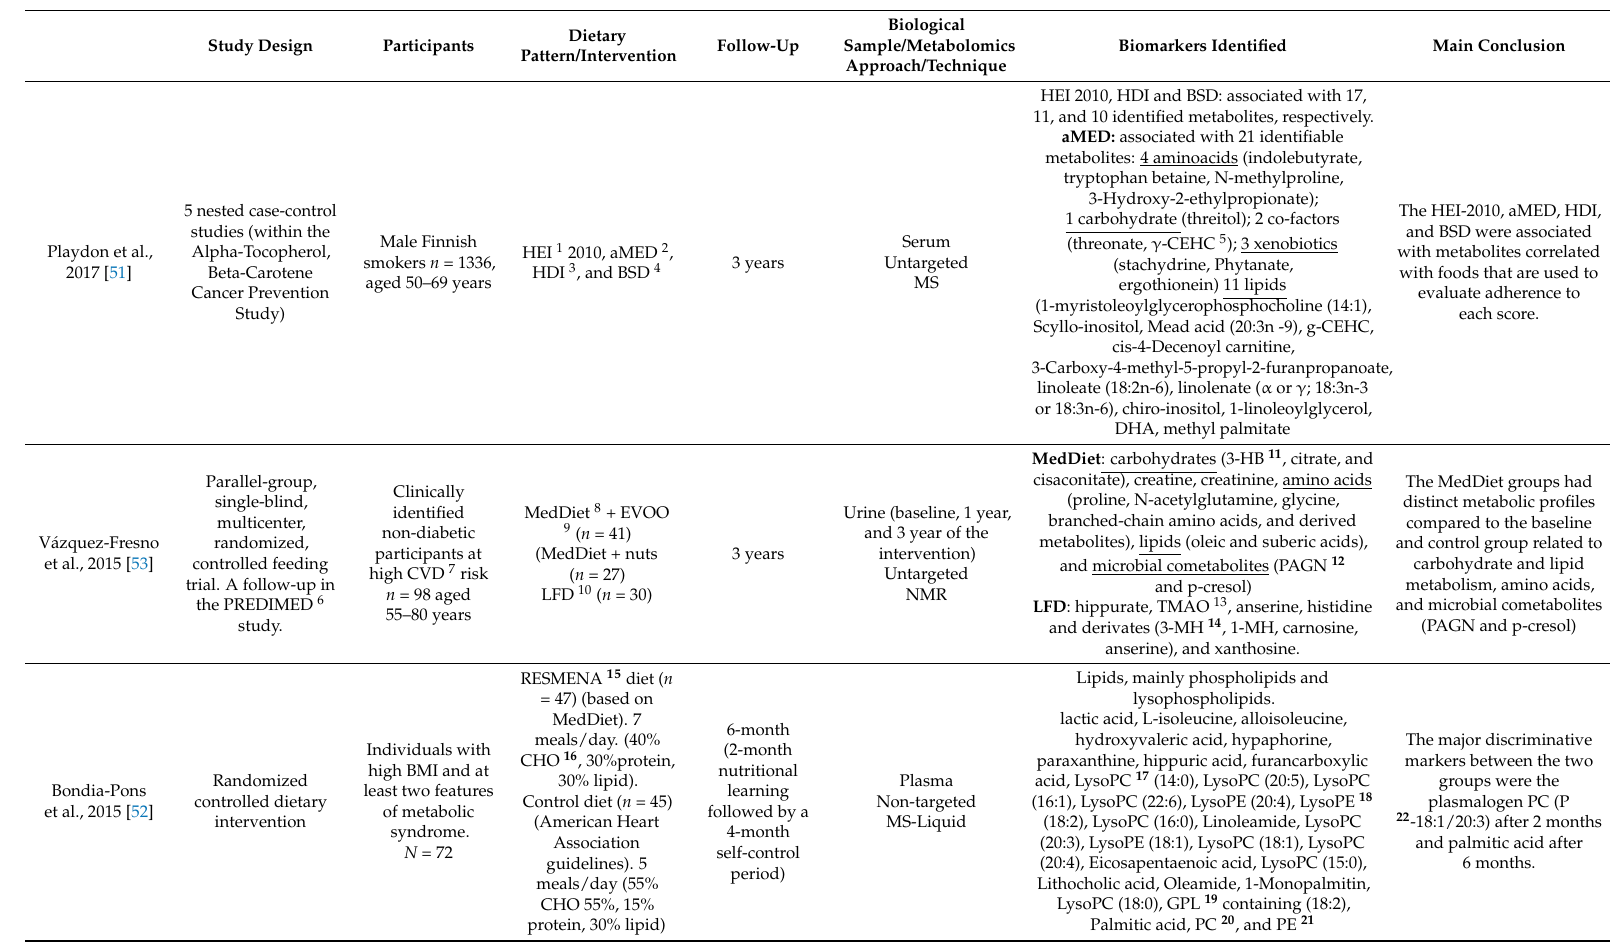
Table 1. Metabolomics as an assessment of the Mediterranean diet (MedDiet) dietary